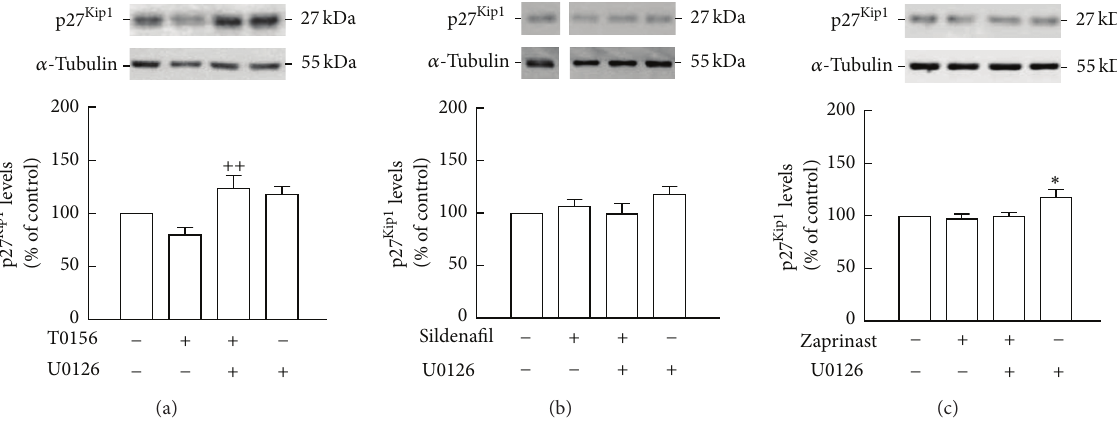
Figure 8: Inhibition of MAPK pathway prevented the decrease of p2 7 Kip 1 levels mediated by T0156. p2 7 Kip 1 levels following treatment with 1 𝜇 M U0126 and 1 𝜇 M T0156 (a), 1 𝜇 M sildenafil (b), or 10 𝜇 M zaprinast (c) for 2h were assessed by Western blot. Representative images are shown. Data are expressed as means ± SEM of at least 5 independent experiments. One-way ANOVA (Bonferroni’s post-test), ∗ 𝑃 < 0.05 , significantly different from control and ++ 𝑃 < 0.01 , significantly different from T0156.